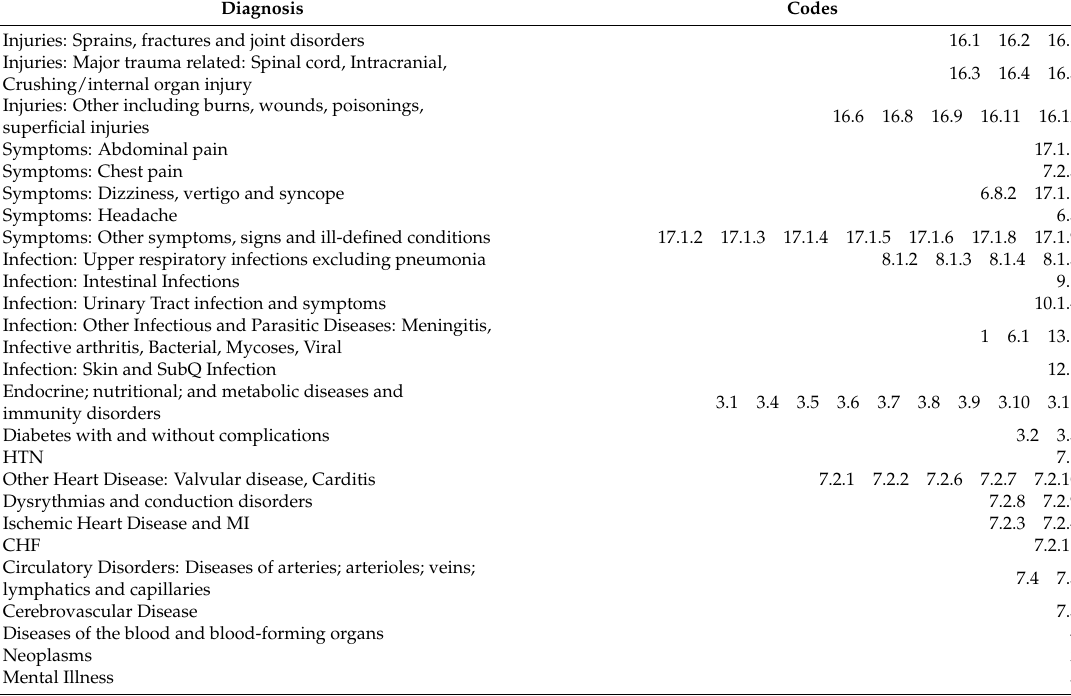
Table A2. Diagnosis